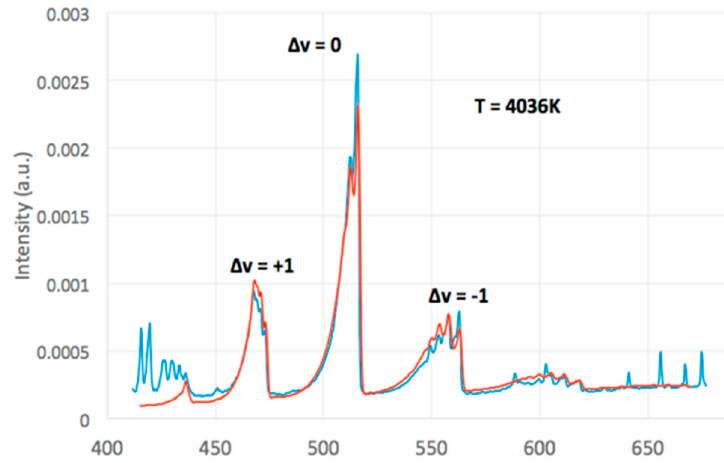
Figure 7. Swan band emission from C 2 (blue) and simulated spectral fit (red), each with vibrational bands as labelled. Overall, T = 4036 K.